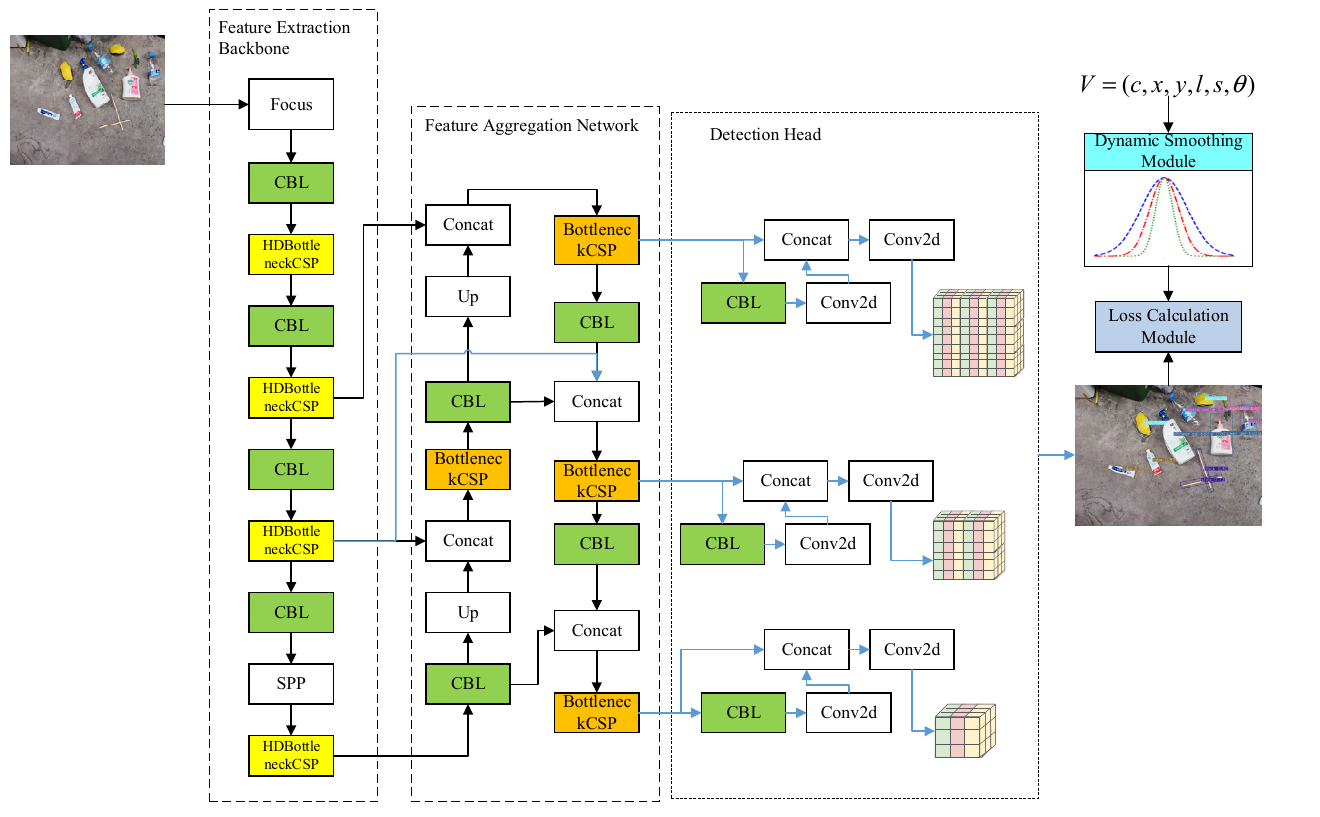
Figure 9. Method diagram for